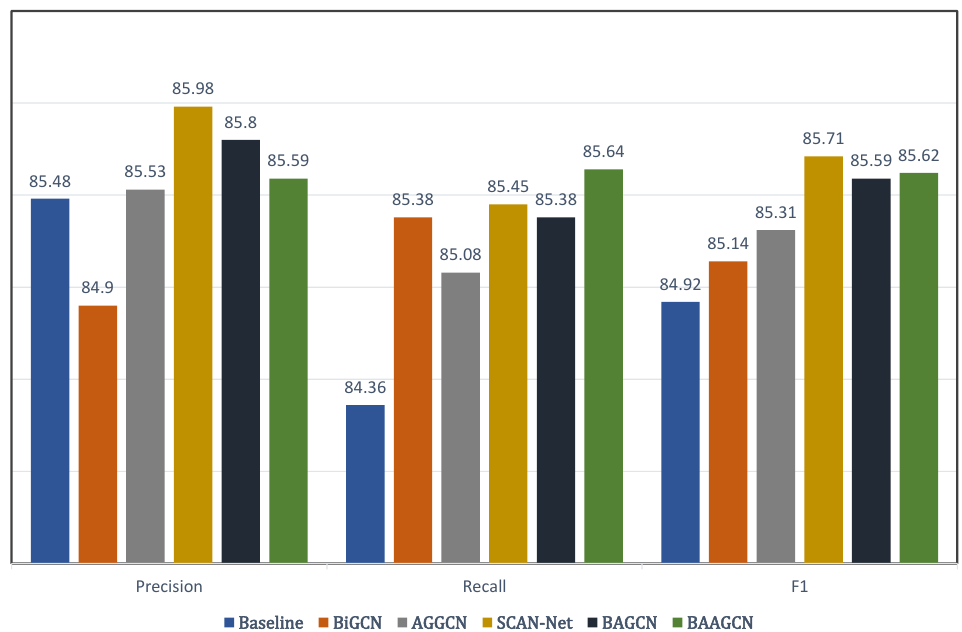
Figure 4. Effect of syntactic information on NER